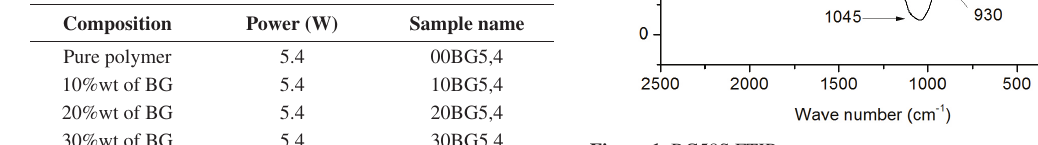
Figure 1. BG58S FTIR